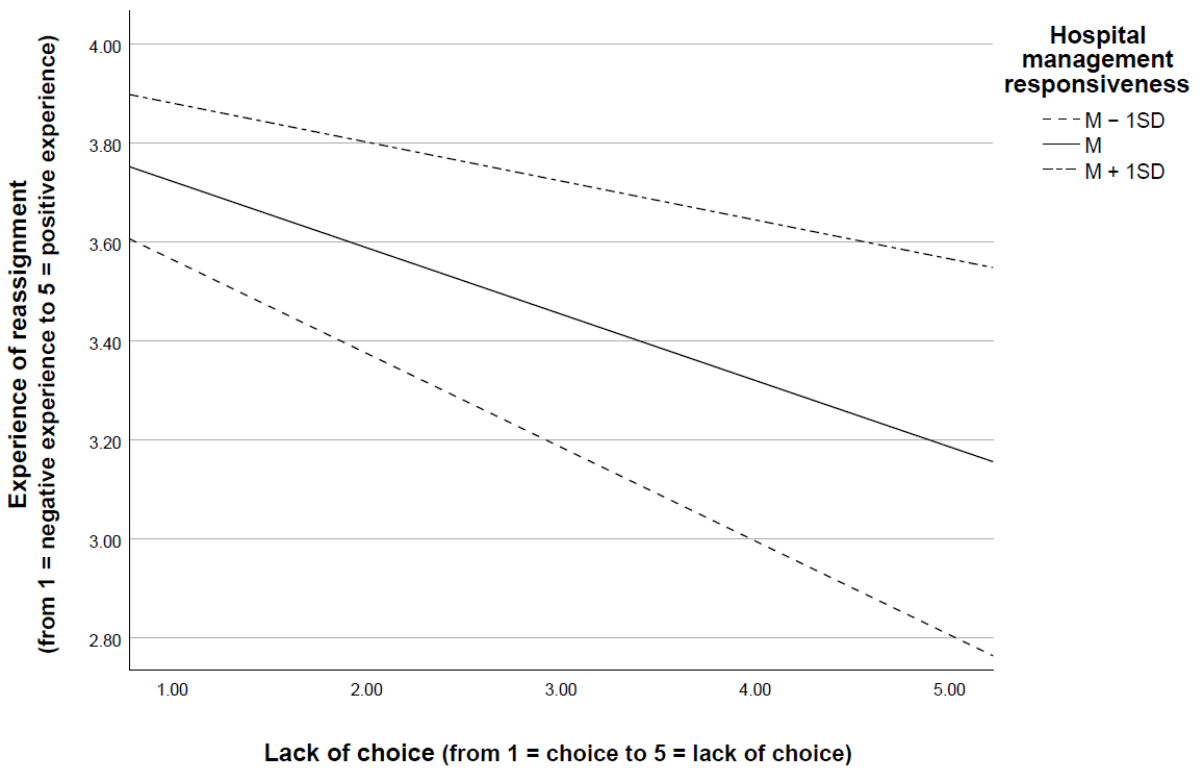
Figure 3. Lack of choice and experience of reassignment at different levels (M and M ± 1 SD) of hospital management responsiveness. Note: M = Mean; M + 1 SD = Mean plus one standard deviation; M − 1 SD = Mean minus one standard deviation.